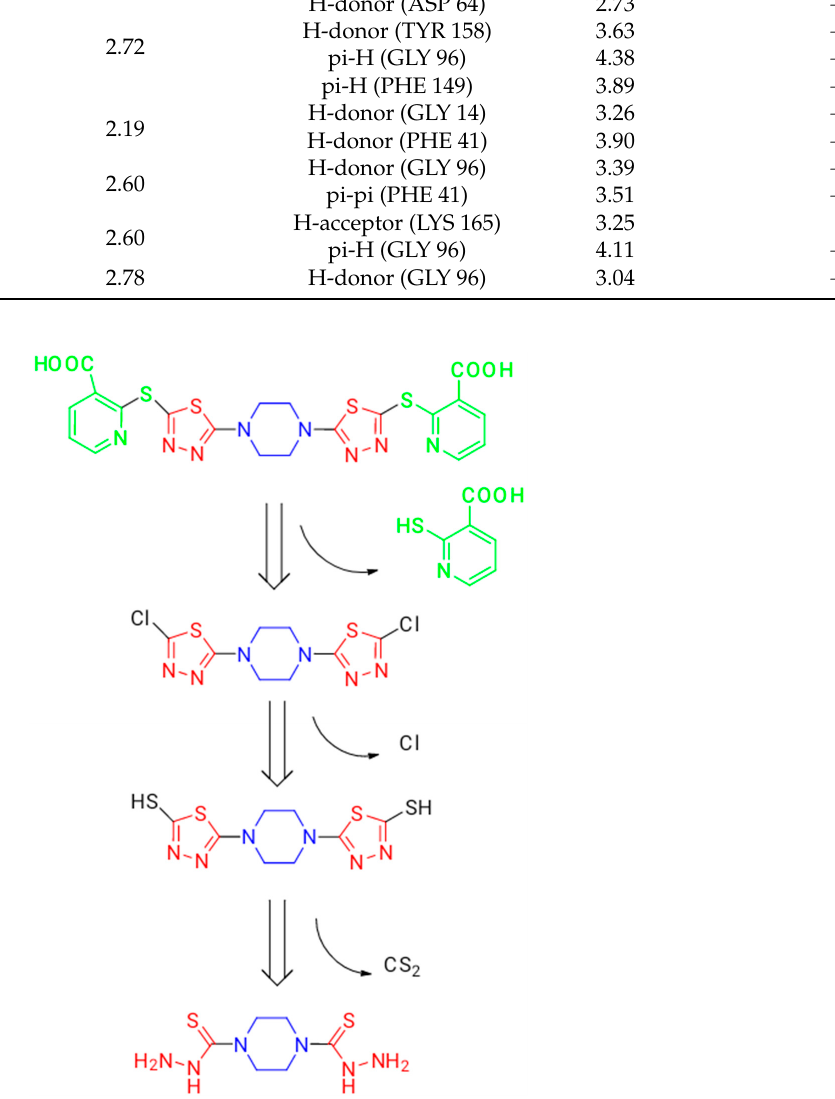
Figure 2. Design strategy of novel piperazines bearing thiadiazole moiety as antimicrobial drugs. In the case of 7a and 7b, which comprised five rings, two were terminal phenyl or pyridyl rings, respectively. Moreover, each terminal ring possessed a carboxy group. Each of these compounds showed hydrogen-bonding interaction with the active site Tyr158.